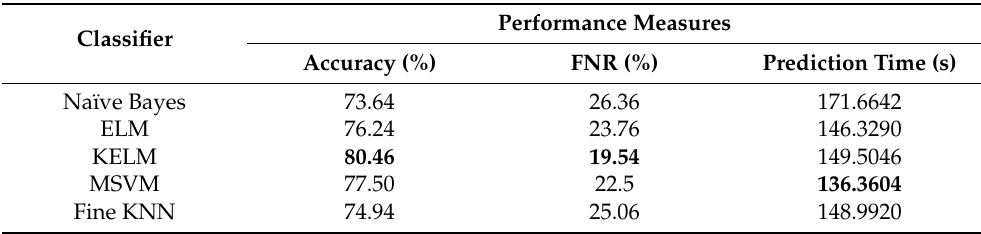
Table 6. Multiple skin lesion type classification results using only the ResNet101 CNN model after transfer learning. Best values are shown in bold.